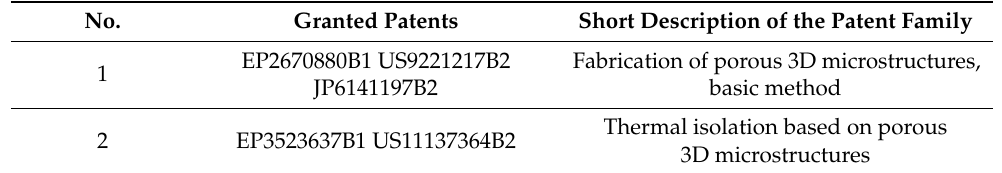
Table 3. Patents related to this